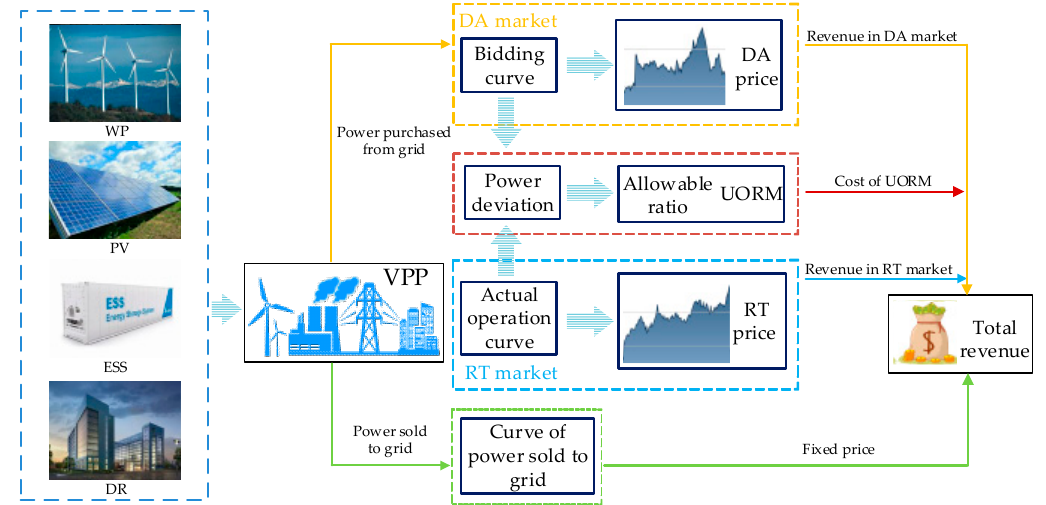
Figure 2. Framework of the virtual power plant (VPP) in the spot market.